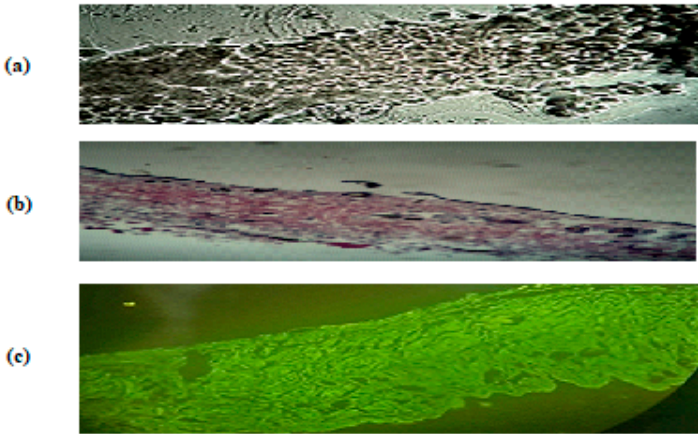
Figure 7. Fluorescence image of rat skin (transactional slice) after Rhodamine loaded nanoparticles permeation: ( a ) skin without treatment, ( b ) visualization under normal microscope and ( c ) green fluoresce exhibiting penetration across stratum corneum.